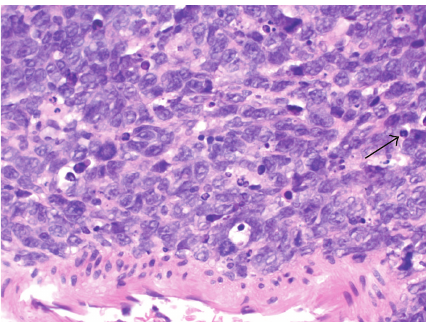
Figure 2: Case 1—hematoxylin and eosin stain of liver biopsy show- ing cells with large, hyperchromatic nuclei with scant cytoplasm and mitosis (black